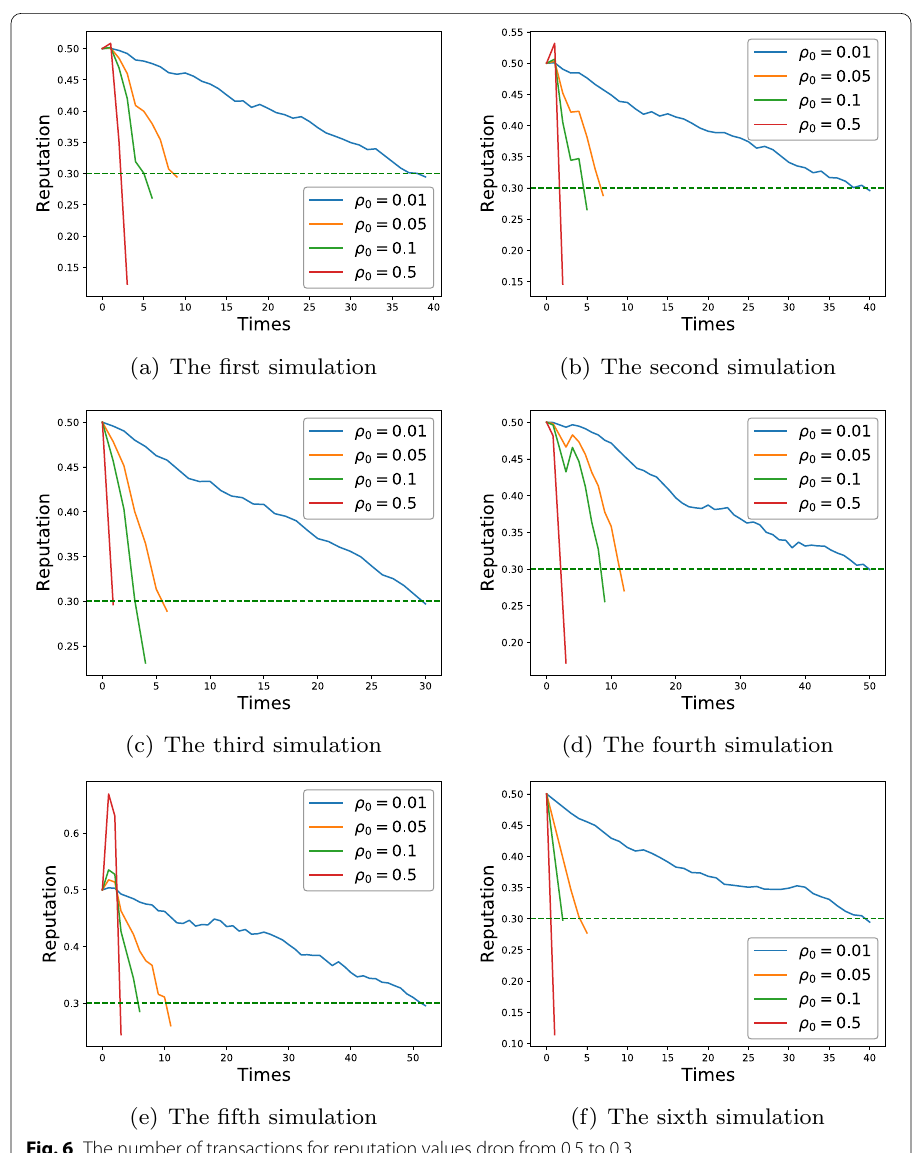
Fig. 6 The number of transactions for reputation values drop from 0.5 to